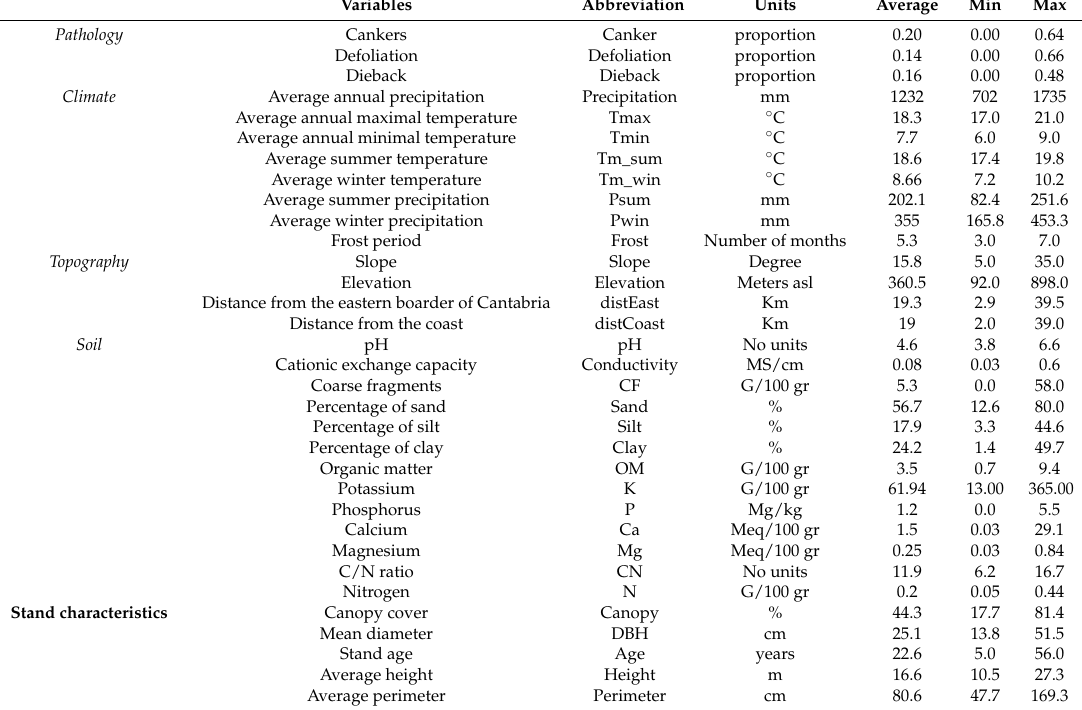
Table 1. Descriptive statistics, across all 50 plots, of the dependent (pathological symptoms) and independent variables used in this study. The proportion of each of the pathological symptoms represents the number of sampled trees out of the 25 in each plot that showed each